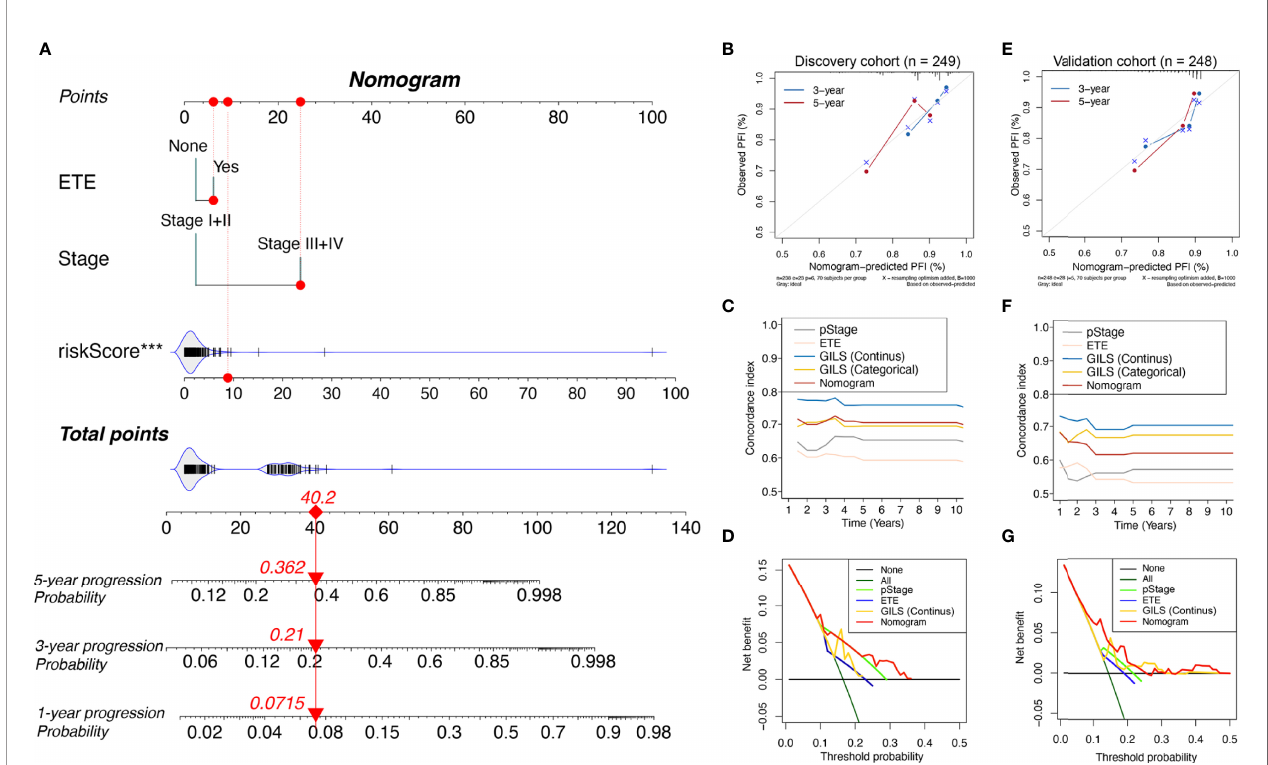
FIGURE 5 | Competing-risk nomogram and the corresponding calibration. (A) Competing-risk nomogram incorporating the extra-thyroidal evasion, tumor stage, and GILS score. Calibration curves, concordance index estimates, and net bene fi t analysis of the competing-risk nomogram in the (B-D) discovery cohort and (E – G) validation cohort. ***p <